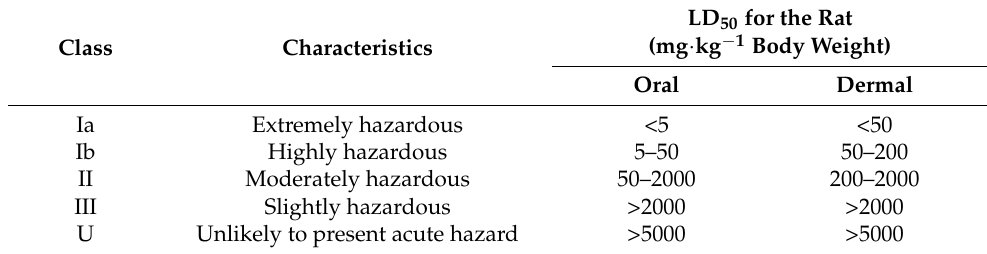
Table 7. Criteria for classification of pesticides.